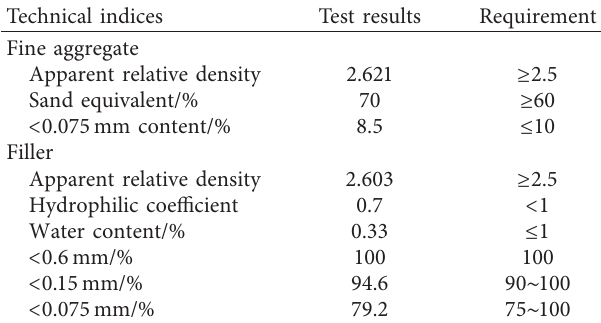
Table 3: Technical indicators of fine aggregate and